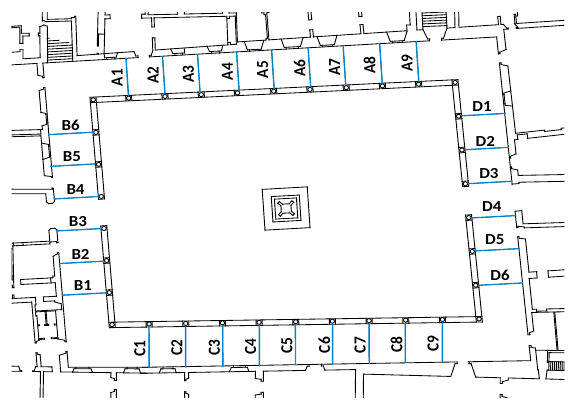
Figure 14. Plan of the inner courtyard of Palazzo Arcivescovile in Pisa: the tested tie-rods are